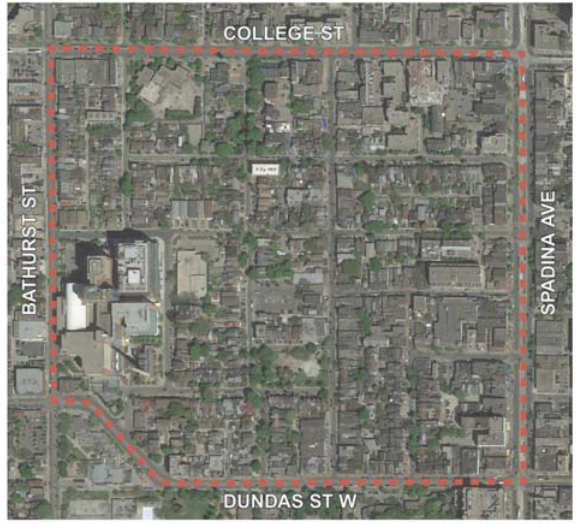
Figure 9: Existing Street facades of the Kensington Market